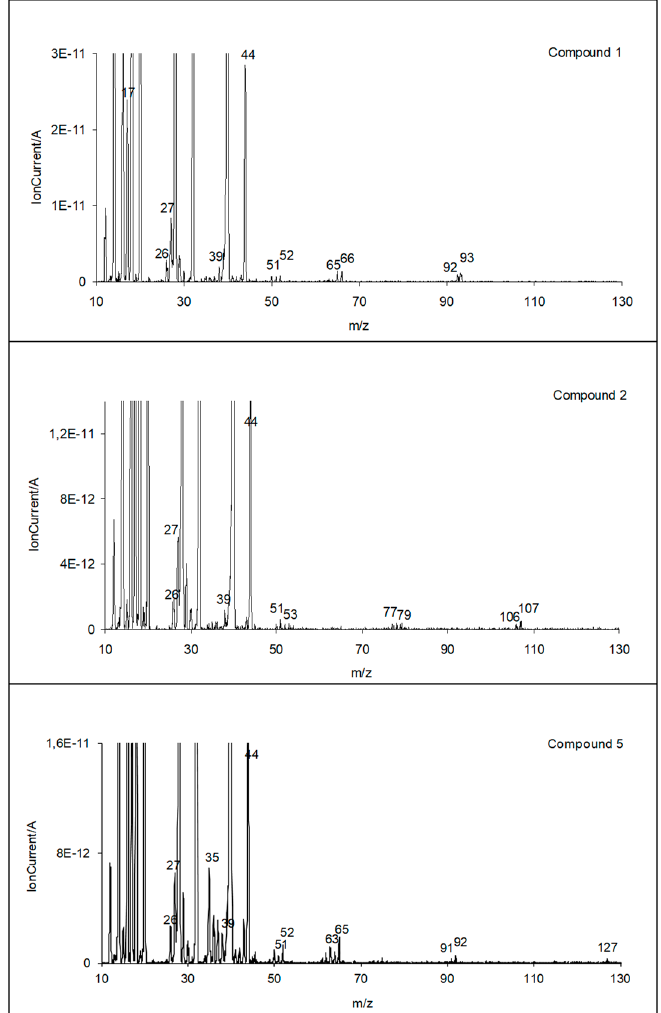
Figure 6. The QMS spectra of volatiles emitted under the heating of the selected compounds (an inert atmosphere).